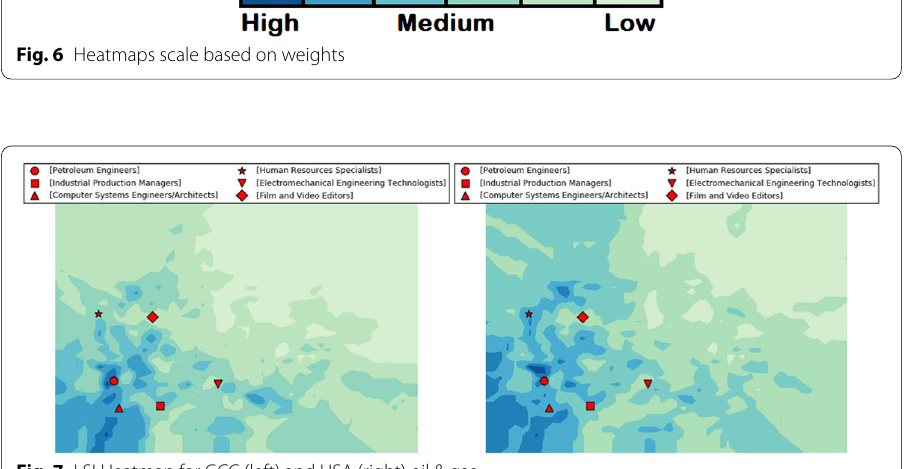
Fig. 7 LSI Heatmap for GCC (left) and USA (right) oil &